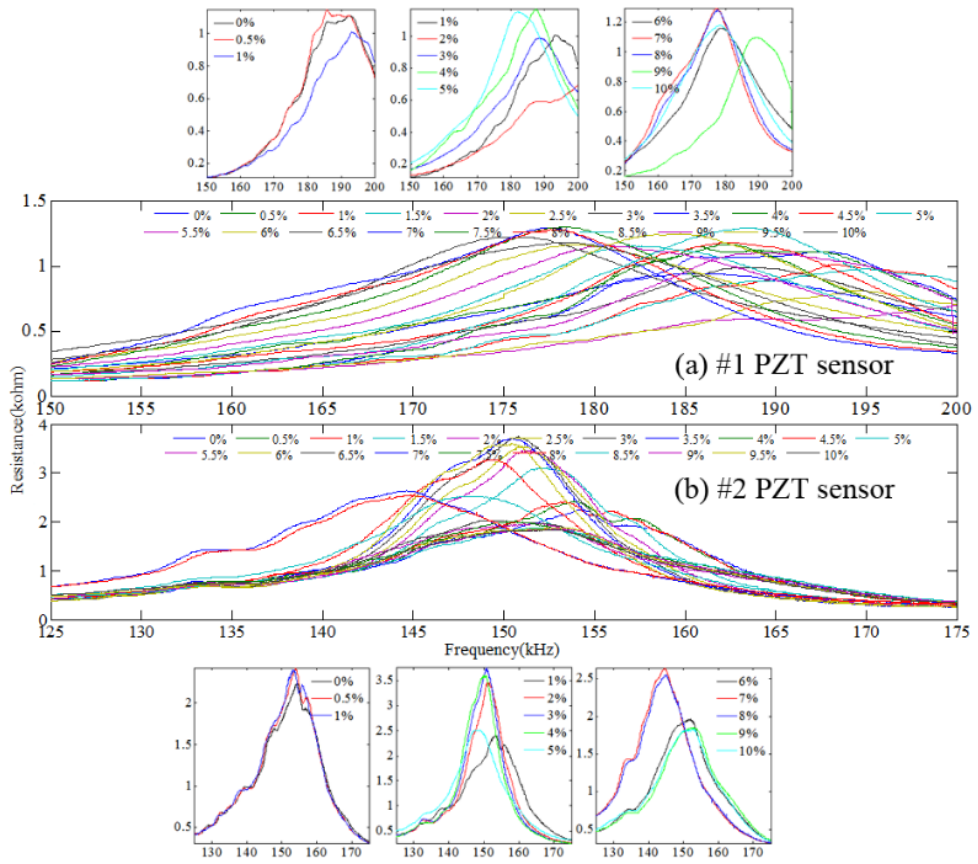
Figure 7. Resistance vs. frequency spectra of PZT transducers in different frequency intervals.